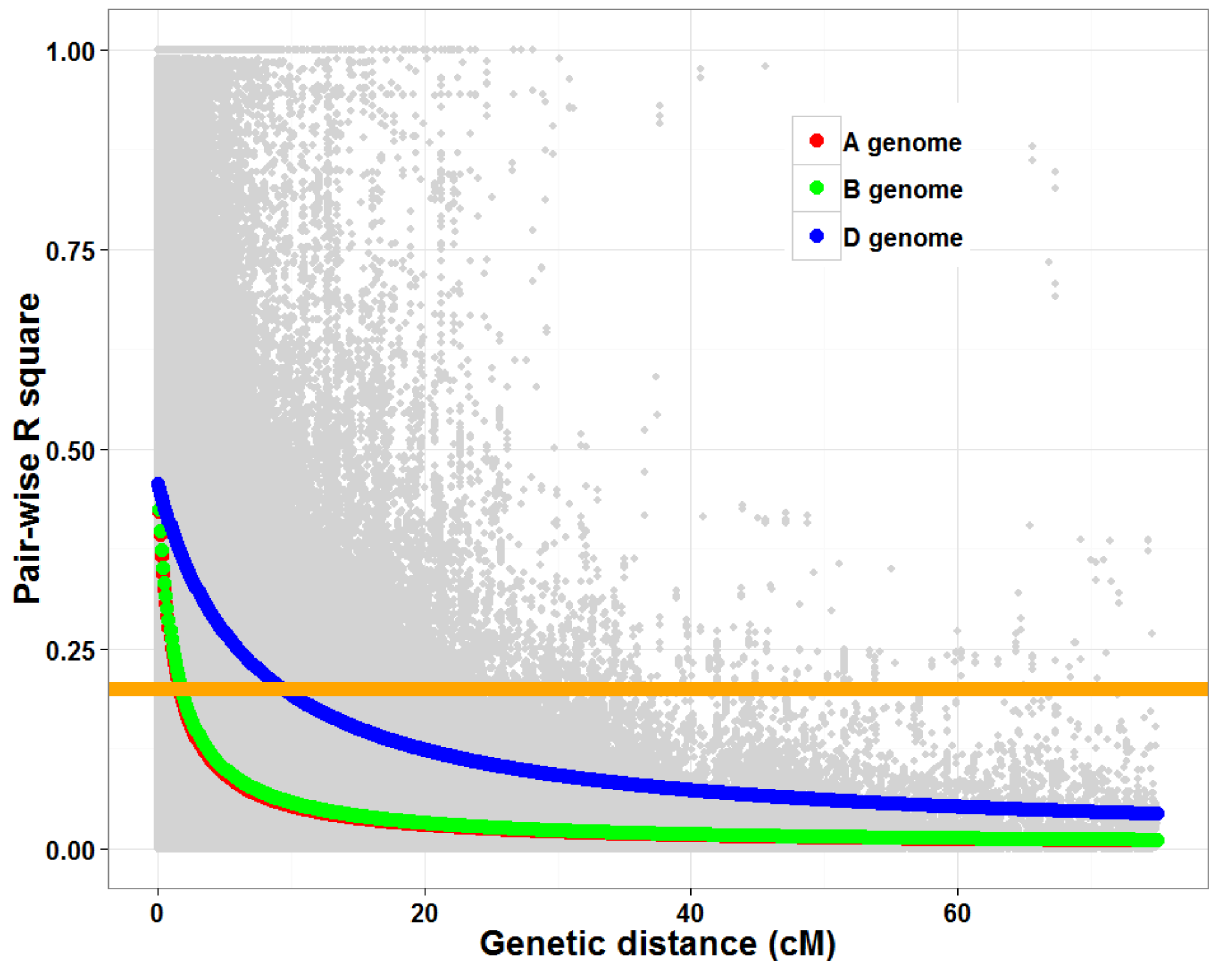
Fig 2. Linkage disequilibrium based on 18924 SNP markers. For color fitted LD decay lines: red represents A genome; green represents B genome; blue represents D genome. Orange bar indicates LD decay level (R2 = 0.2).